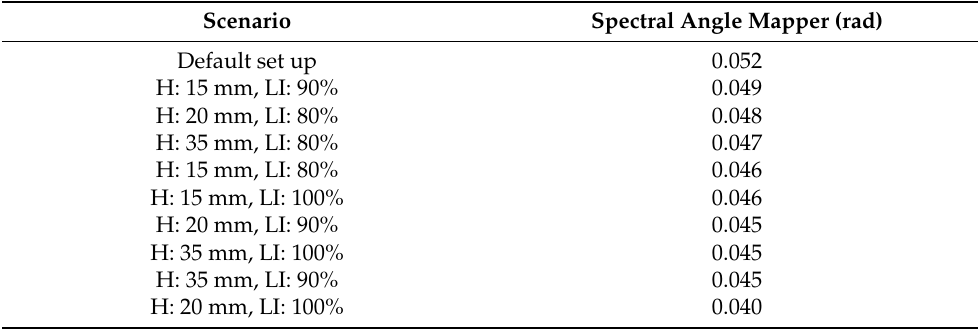
Table 2. Classification of evaluated scenarios according to their performance, evaluated with Spectral Angle Mapper (H: height and LI: light intensity).